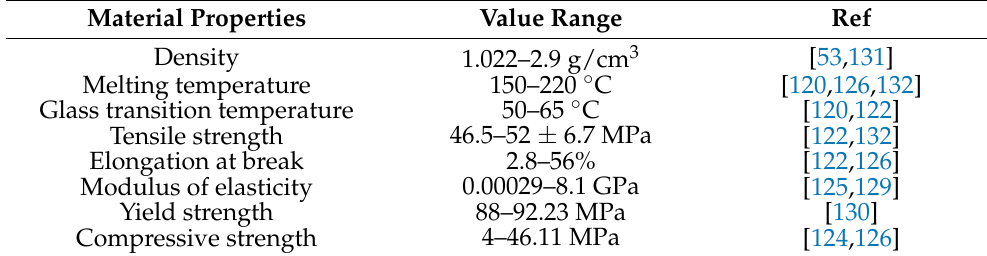
Table 2. Physical and mechanical properties of PLA and its composite material.